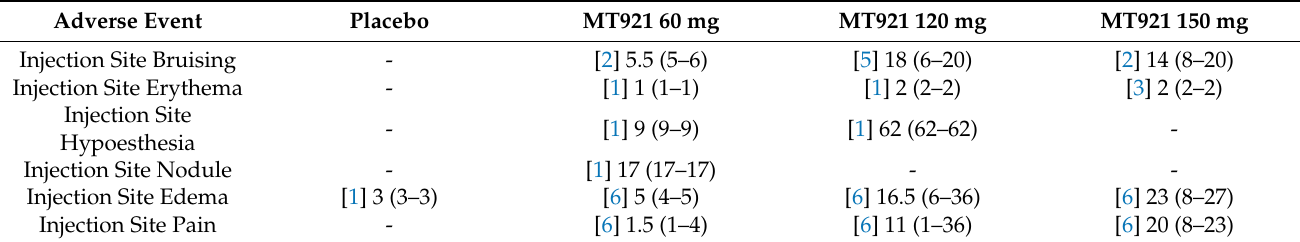
Table 4. Number of subjects and duration of treatment-emergent adverse events. Adverse